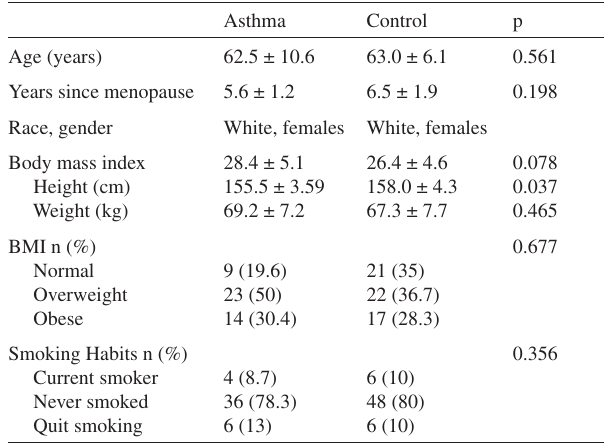
Table 1 - Demographic characteristics of patients in this study